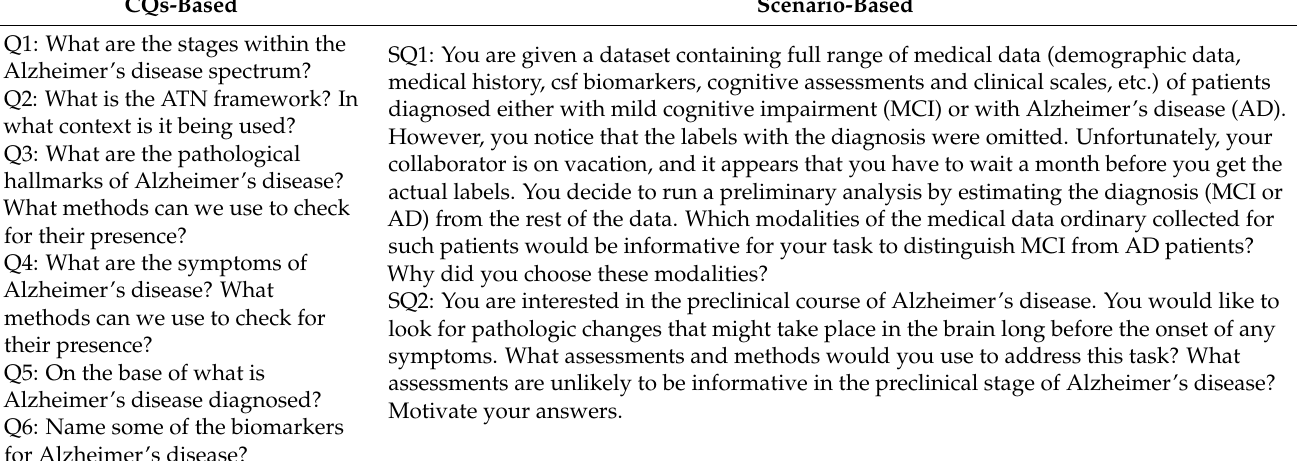
Table 1. CQ-based and scenario-based questionnaires for assessment of AD-DPC. The left panel contains the questions used to estimate the level of correctness and the right panel shows the two scenario-based questions used to assess the